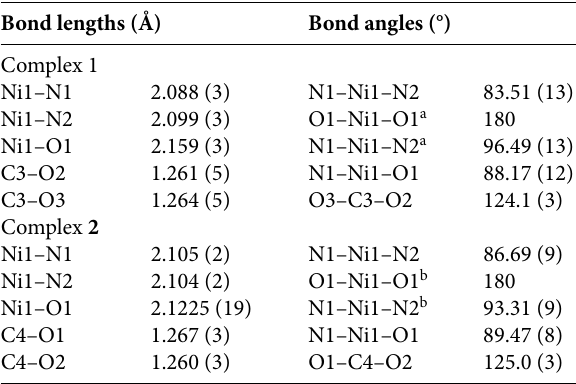
Table 2. Selected bond lengths (Å) and angles (°) in complexes 1 and 2 Bond lengths (Å)